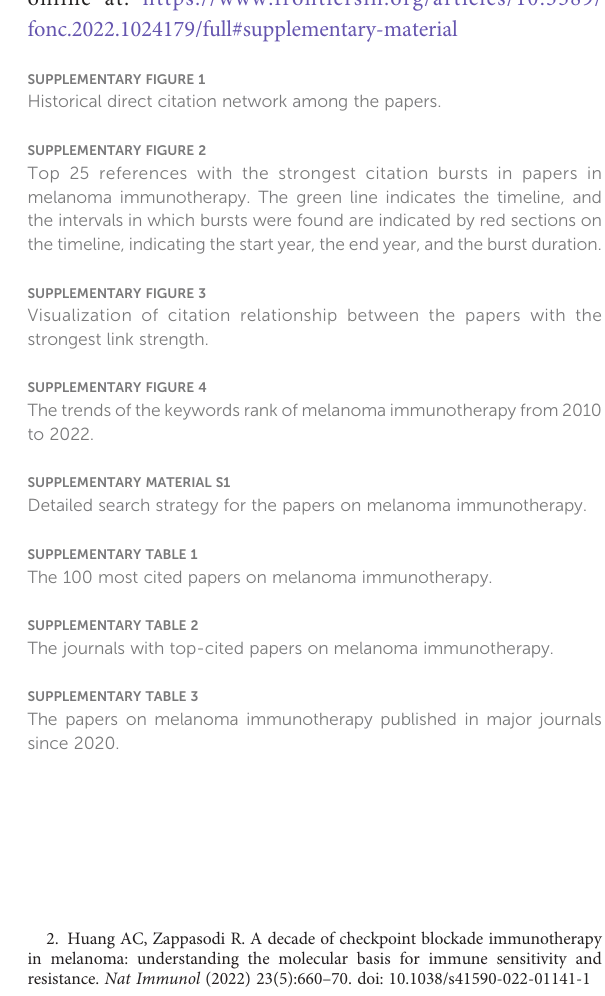
SUPPLEMENTARY TABLE 1 The 100 most cited papers on melanoma immunotherapy. SUPPLEMENTARY TABLE 2 The journals with top-cited papers on melanoma immunotherapy. SUPPLEMENTARY TABLE 3 The papers on melanoma immunotherapy published in major